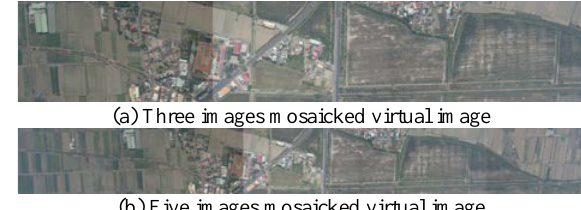
Figure 9. Examples of three and five images mosaicked virtual image